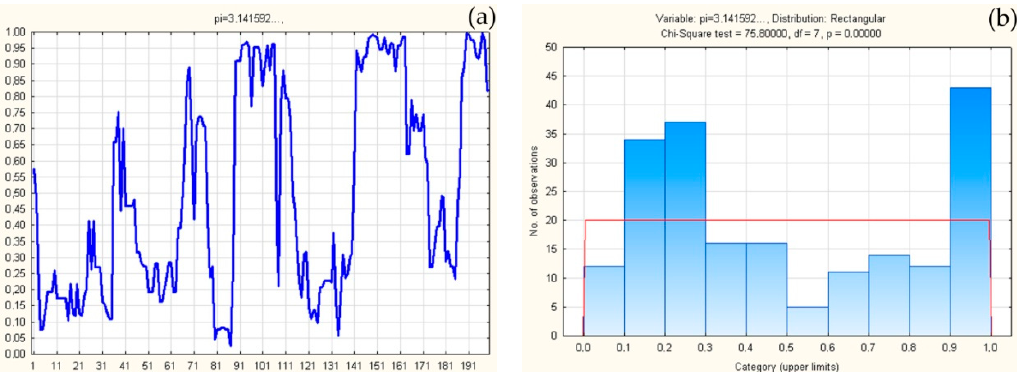
Figure 5. Exponential distributions of all 200 sets Δ↓ [ π (i)] ( a ), verifications, and distribution of verifications ( b ).